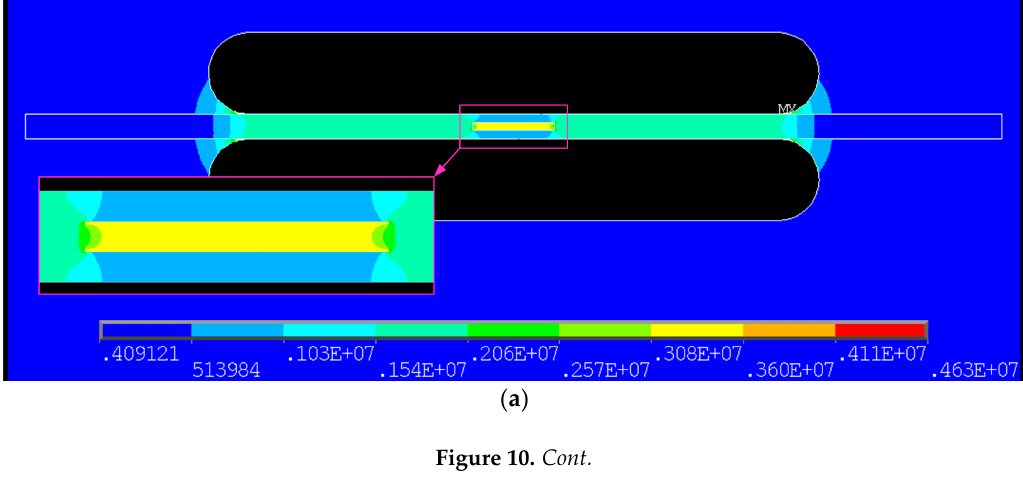
Figure 9. Electric field distribution of surface discharge model under AC and DC voltage components. ( a ) AC voltage component; ( b ) DC voltage component.